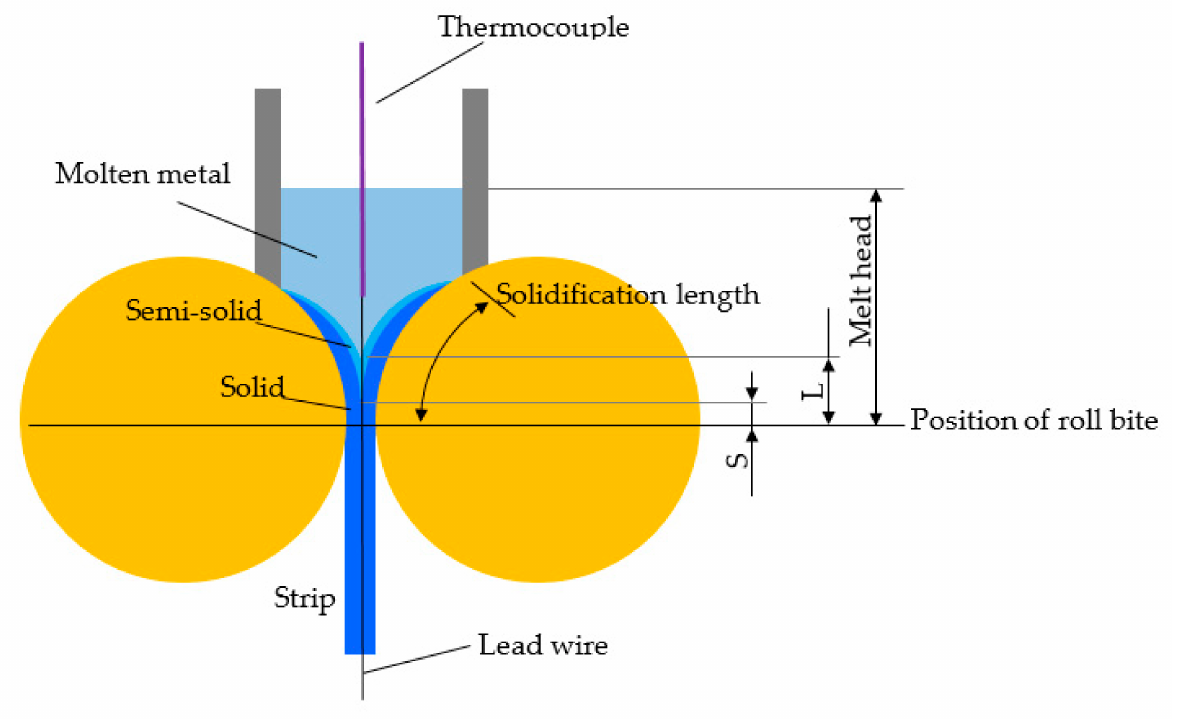
Figure 19. Schematic illustration showing measurement of the temperature of the metal solidified by the twin roll caster. L: position of liquidus line; S: position of solidus line.